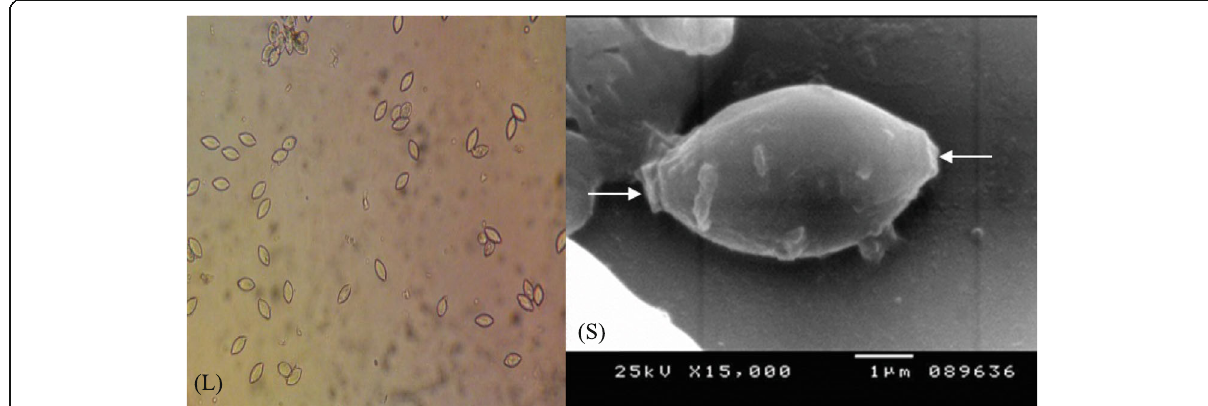
Fig. 5 Light (L) and scanning electron (S) microscope views of Farinocystis spores isolated from Tribolium castaneum (×400 magnification). Note the polar plugs